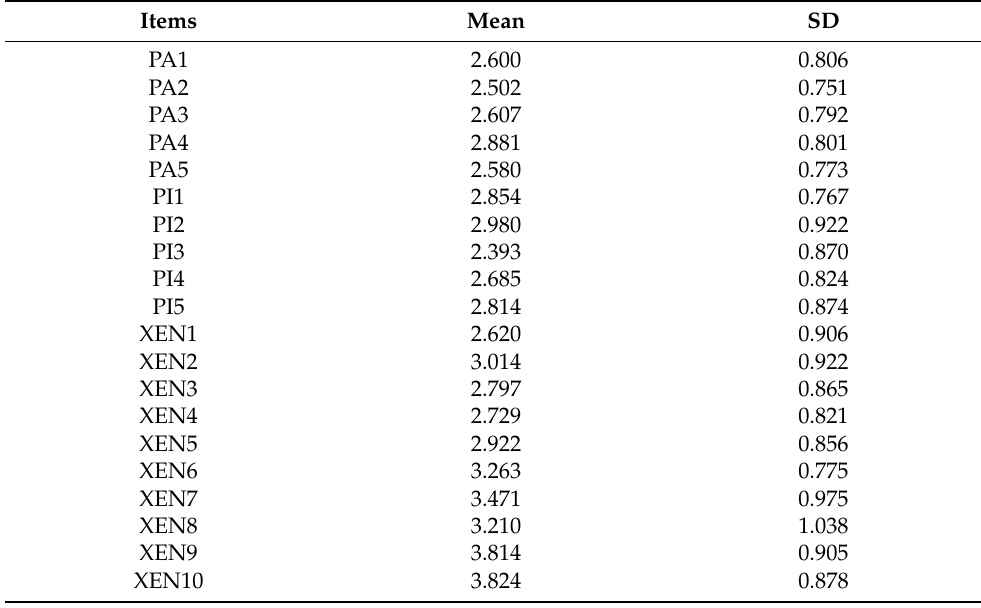
Table A2. Mean and standard deviation of